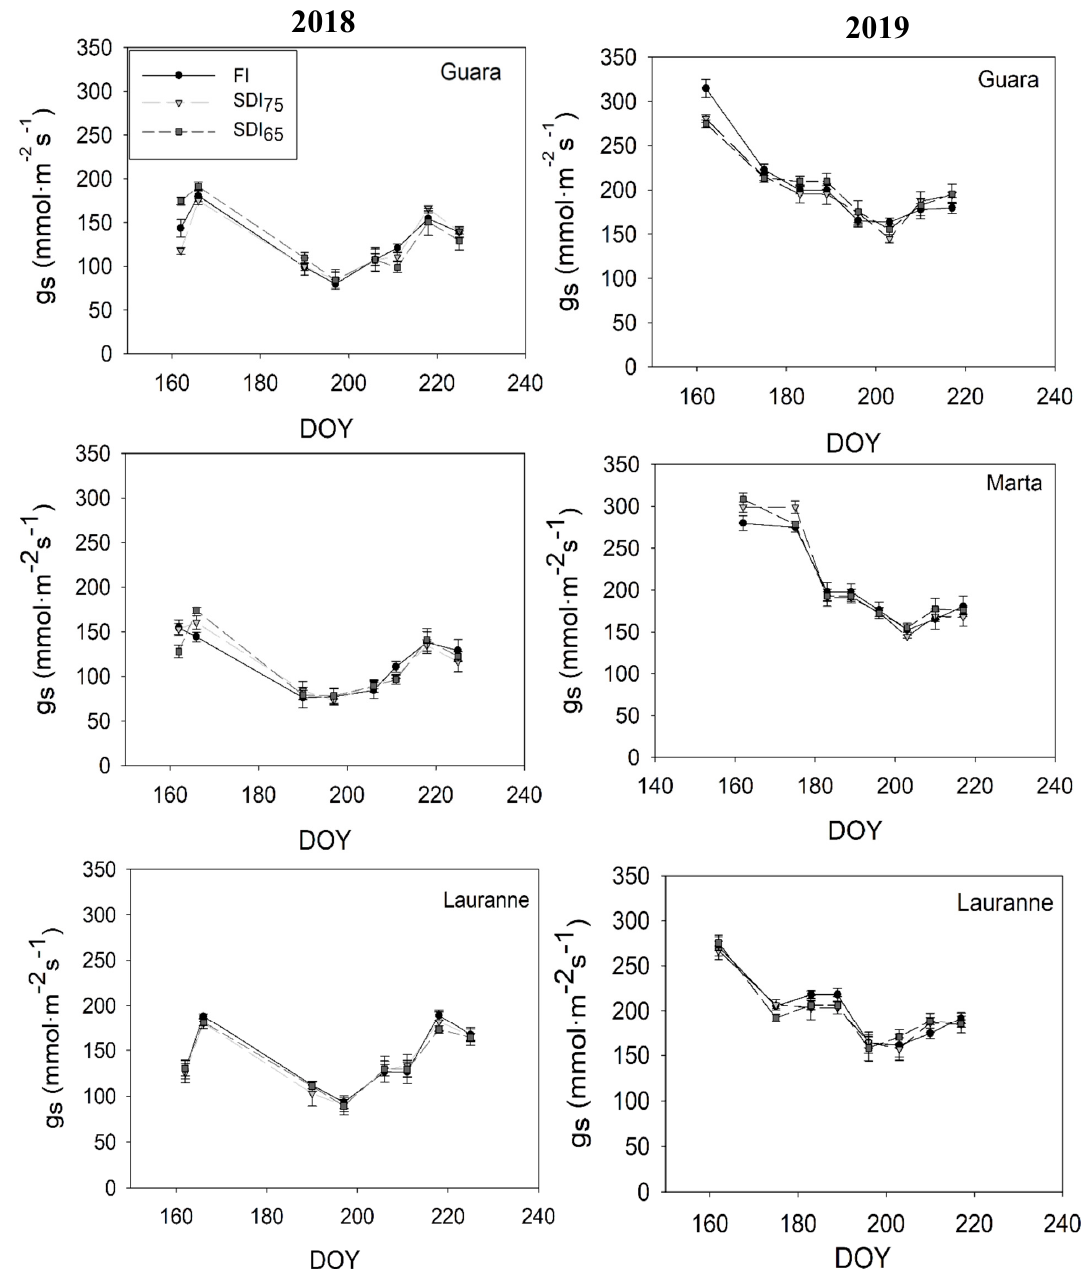
Figure 3 . Seasonal dynamics of stomatal conductance (g s ) during 2018 and 2019. FI, Full irrigated treatment; SDI 75 , sustained-deficit irrigation at 75% IR; SDI 65 , sustained-deficit irrigation at 65% IR, DOY; Day of the year. Vertical bars are standard deviation. Asterisks show the intervals with significant differences between FI and SDI treatments ( p < 0.05).